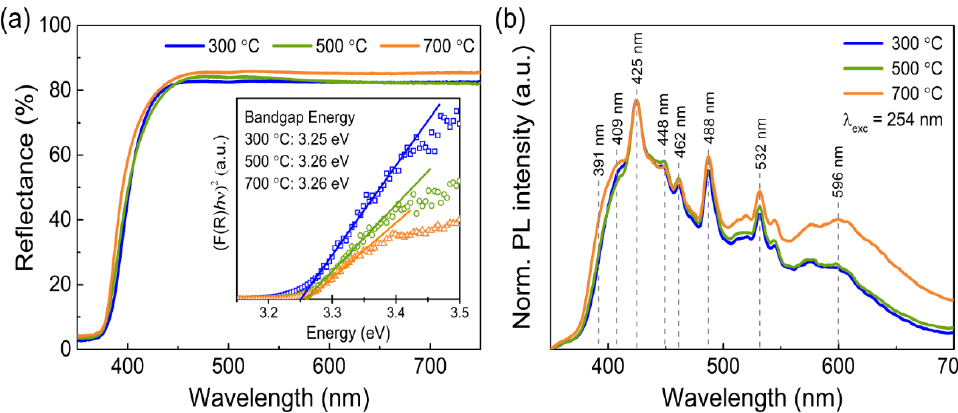
Figure 3. ( a ) Reflectance spectra of the porous ZnO nanostructures calcinated at 300, 500, and 700 °C with an inset graphic showing the obtained bandgap energy for each calcination temperature through the K-M function. ( b ) Photoluminescence spectra of the porous ZnO samples measured with an excitation wavelength of 254 nm.